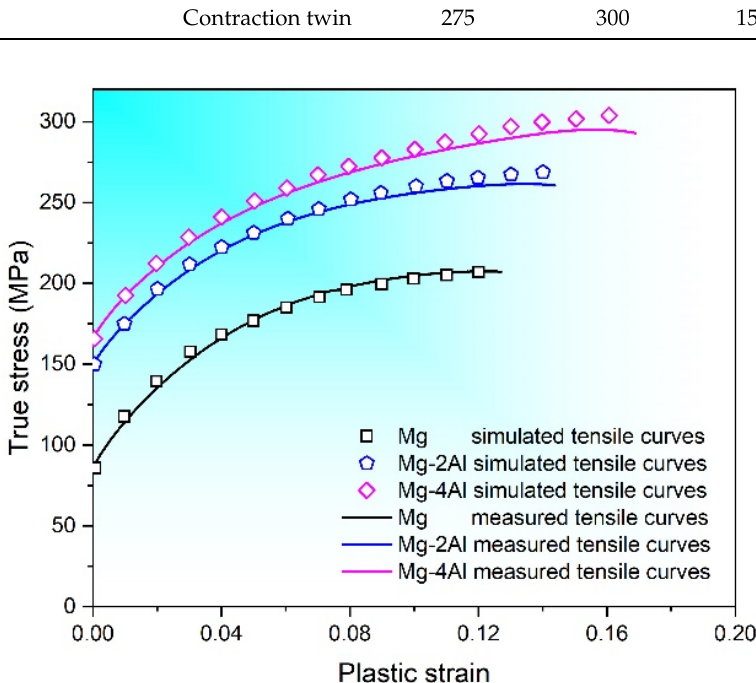
Figure 8. Measured and simulated flow curves for Mg–xAl (x = 0, 2, 4) alloys. Figure 9 is the relative activity of deformation behavior. According to the curves, relative activities change with the increase of plastic strain. Figure 9a illustrates that basal slip is the overriding deformation mode in Mg. In Figure 9b,c, at the beginning of tensile process, deformation modes of Mg–Al alloys are given priority to with basal slip, while extension twins are the auxiliary deformation mode. Besides, the relative activity of extension twins increases from 0 to 0.05, even it fades away soon, and the prismatic slip starts immediately. When strain comes to 3%, prismatic slip mainly replaces extension twins. Afterward, prismatic slip shows an increasing tendency which makes basal slip come down at the same time. At the end of the plastic tensile test, relative activity of prismatic slip rises to 0.22 and 0.35 in Mg–2Al alloy and Mg–4Al alloy respectively, while basal slip falls to 0.76 and 0.62. In a word, the simulation results show that basal slip plays a decisive part in the deformation mechanism in Mg, while the activations of extension